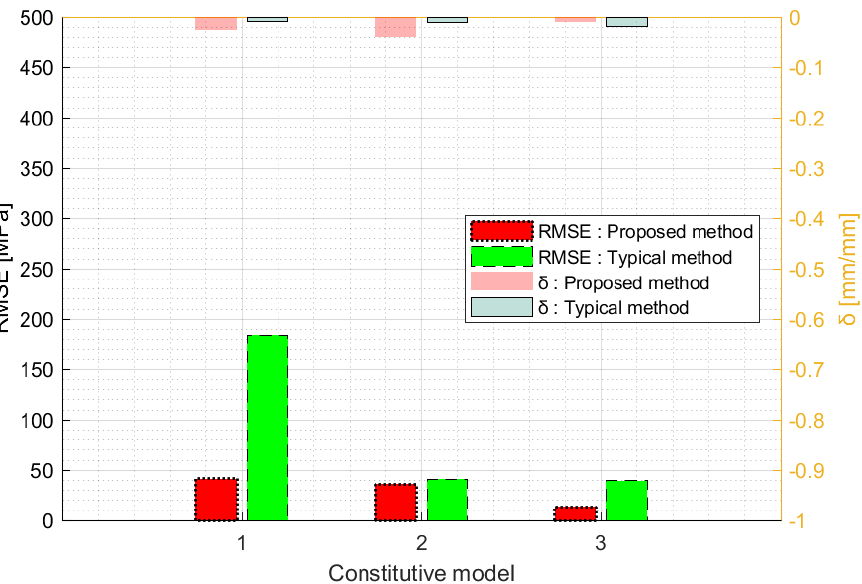
Figure 11. Comparison between the inverse method of the typical and proposed methods based on the RMSE values.